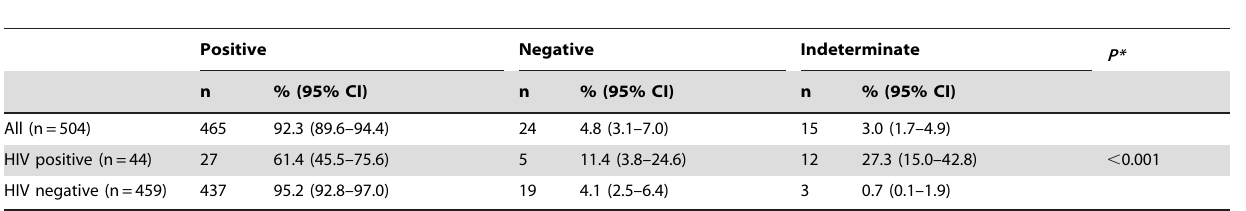
Table 2. QFT-IT results and HIV status in smear-positive/culture-positive pulmonary TB patients.